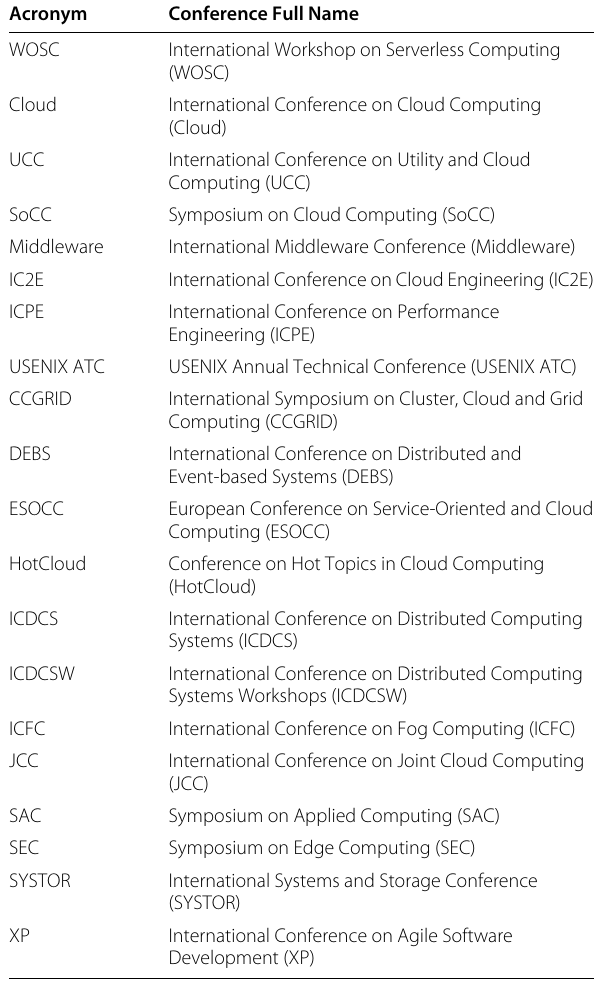
Table 3 List of active